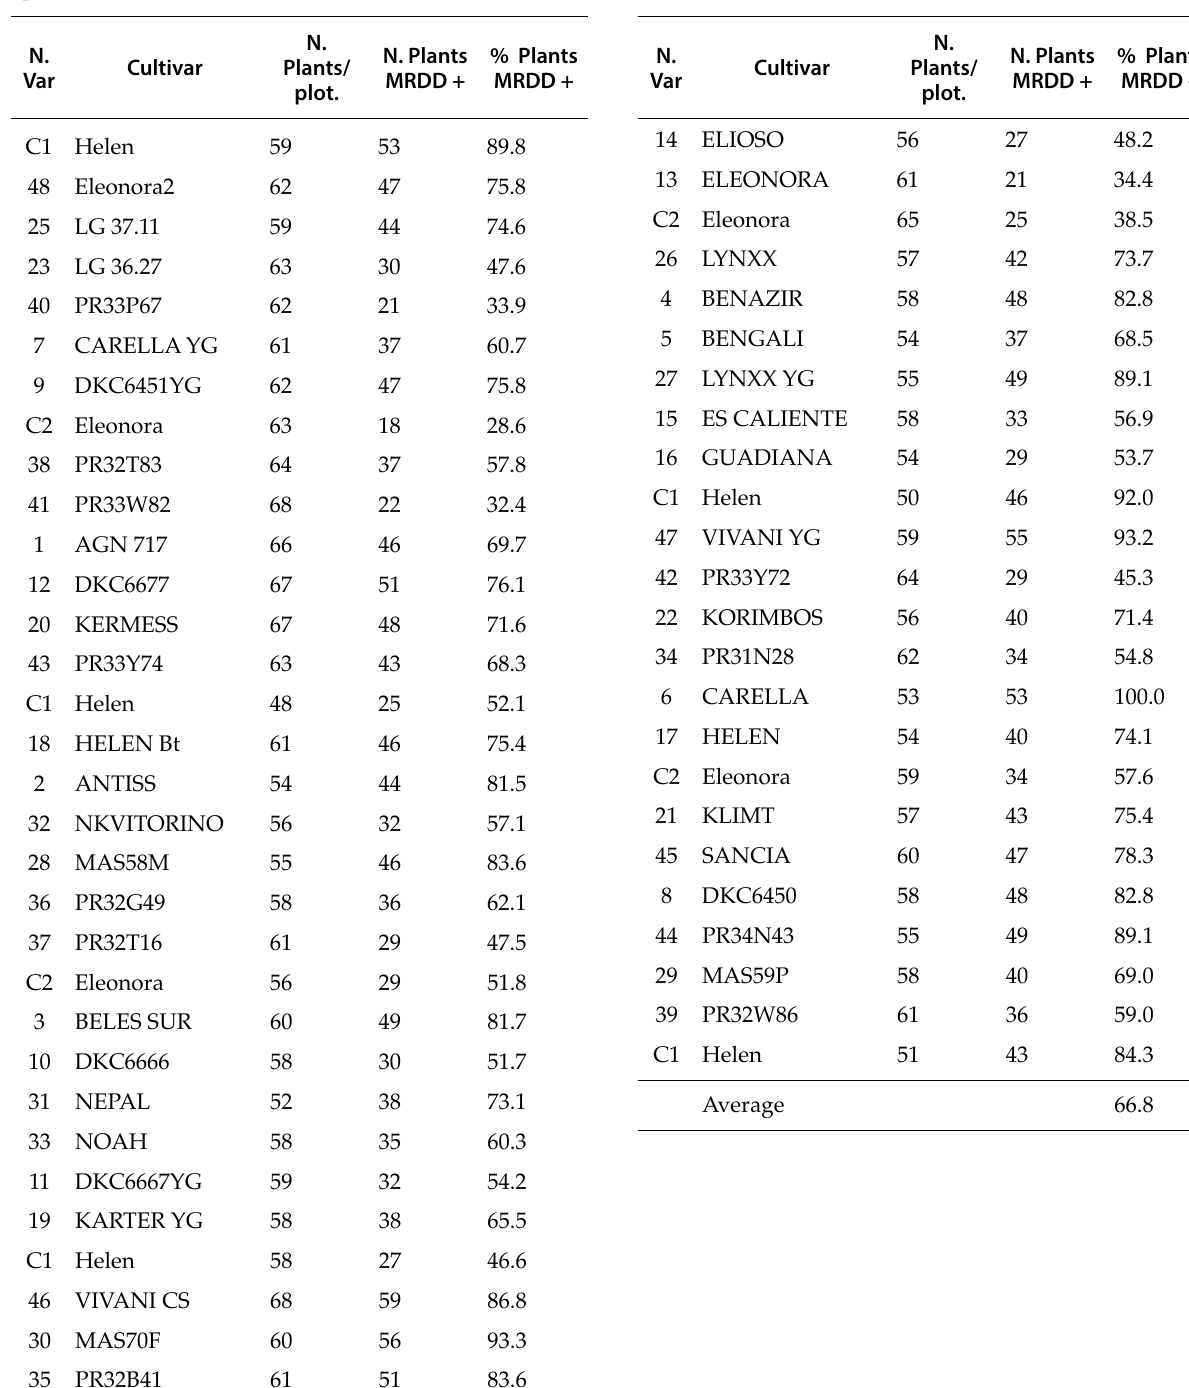
N. N. Plants % Plants Plants/ MRDD + MRDD plot.